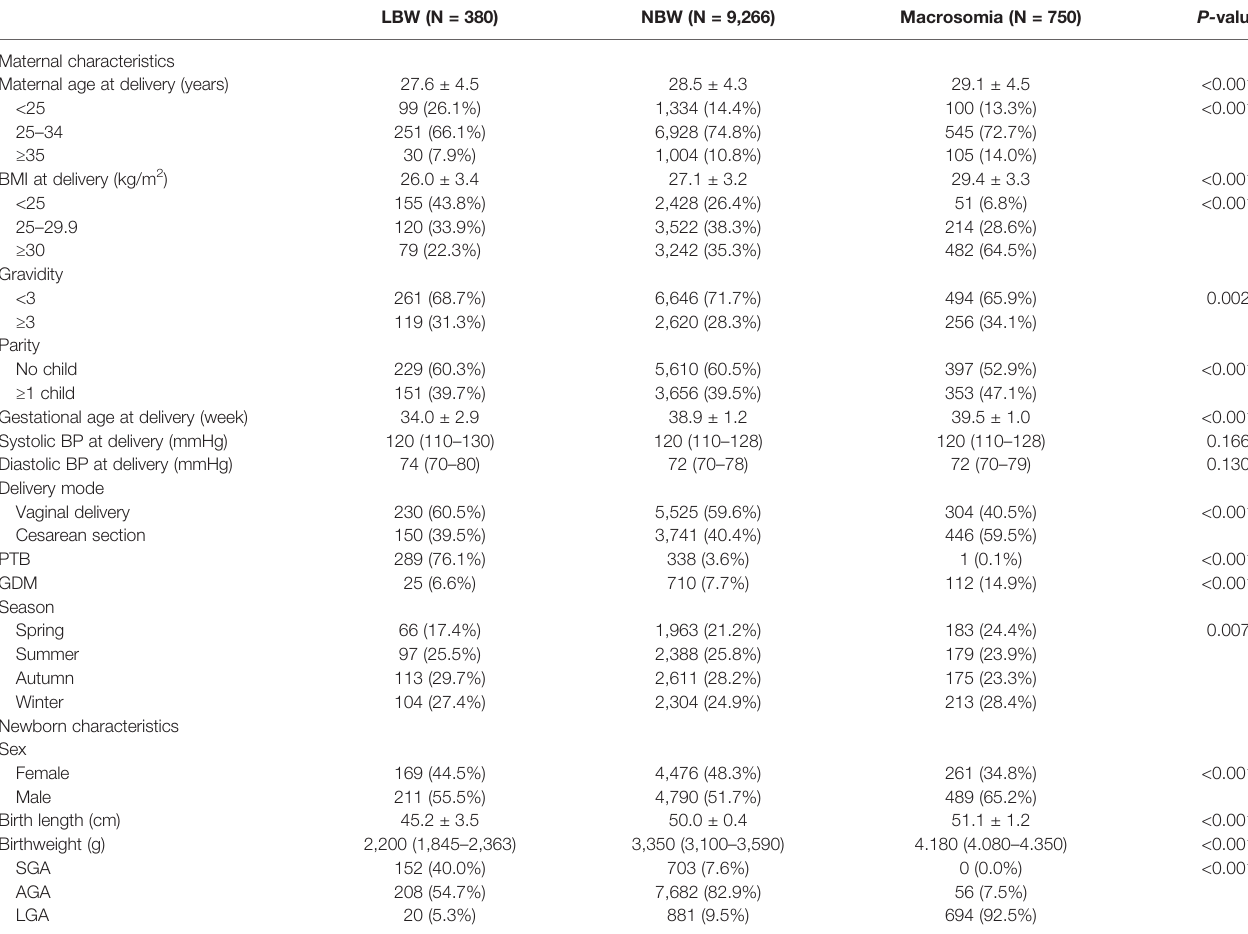
TABLE 1 | Maternal and neonatal characteristics in the study populations according to the